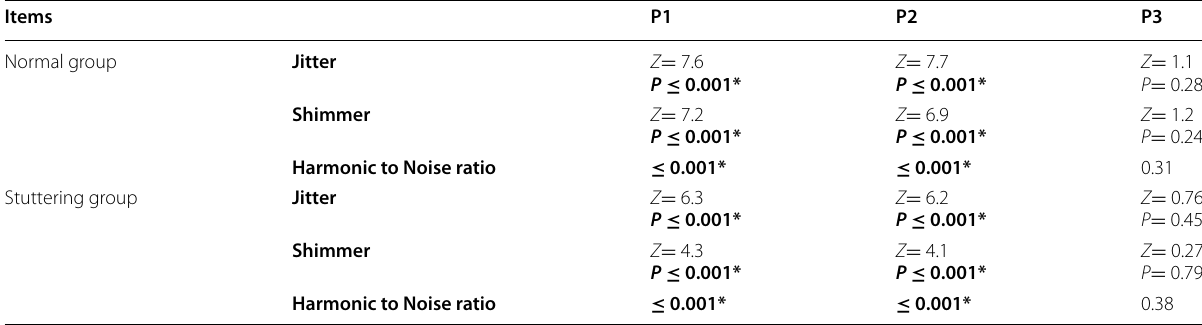
P1 , prolonged /a / vowel vs automatic speech; P2 , prolonged /a / vowel vs spontaneous speech; P3 , automatic speech vs spontaneous speech; Z , Mann-Whitney test Significant difference between groups regarding harmonic to noise ratio is done by post hoc LSD test *Significant p 0.05 ≤ Table 6 Association between acoustic parameters and gender in the normal and stuttering groups